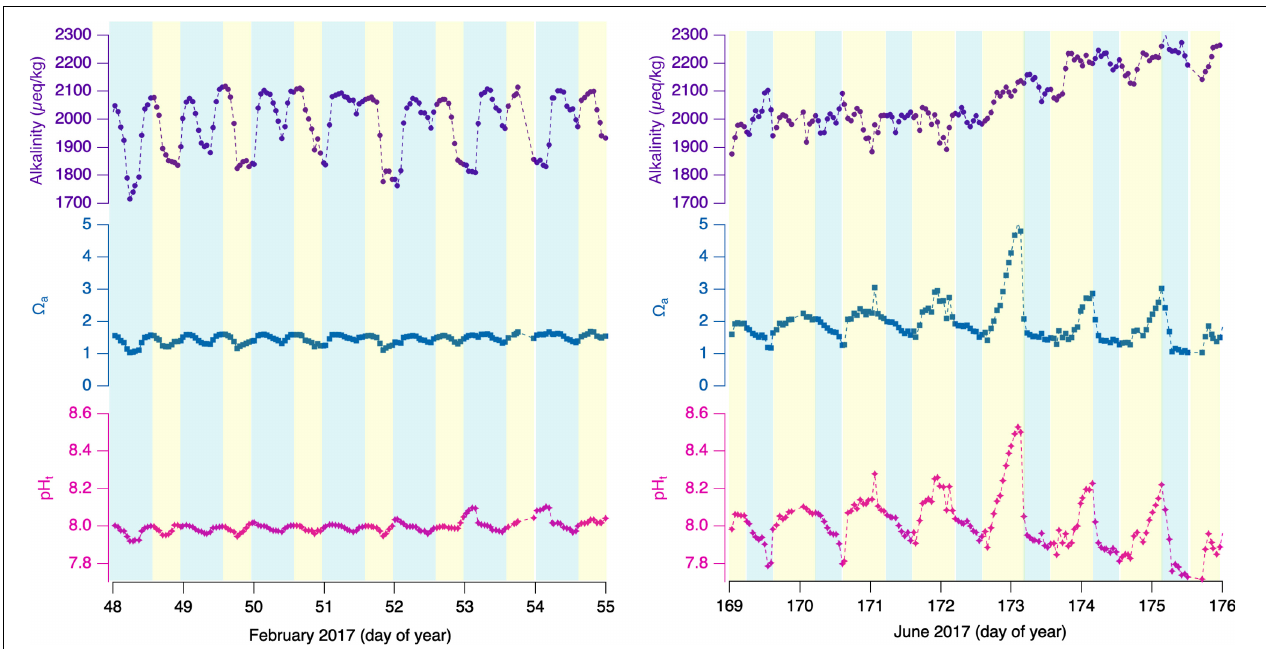
FIGURE 3 | 7-day period winter (Left) and summer (Right) 2017 for Netarts Bay, OR. Calculated alkalinity (purple dots connected by dashed line), saturation state of aragonite ( (cid:127) a , blue squares connected by dashed line), and pH (pink stars diamonds connected by dashed line). Blue shading indicates local nighttime and yellow shading indicates